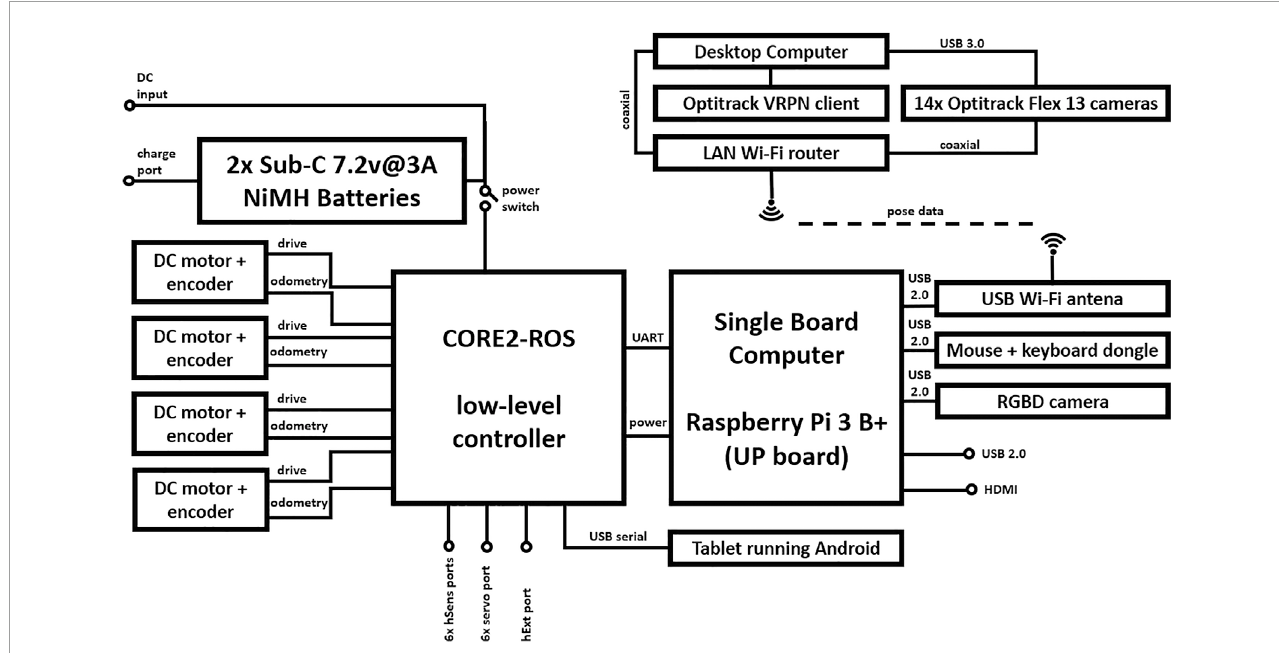
FIGURE 3 Graphic representation of the components integrating the proposed robotic platform and the connections between them.